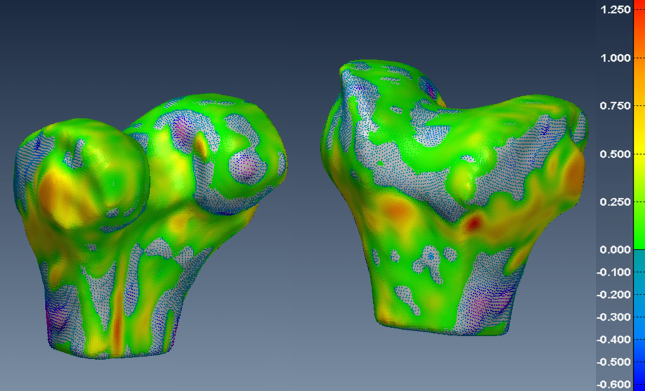
Figure 17. Two views of the colour-coded signed distance in mm between the U-Net mesh and the SKI10 mesh for the femur with the optimal threshold.